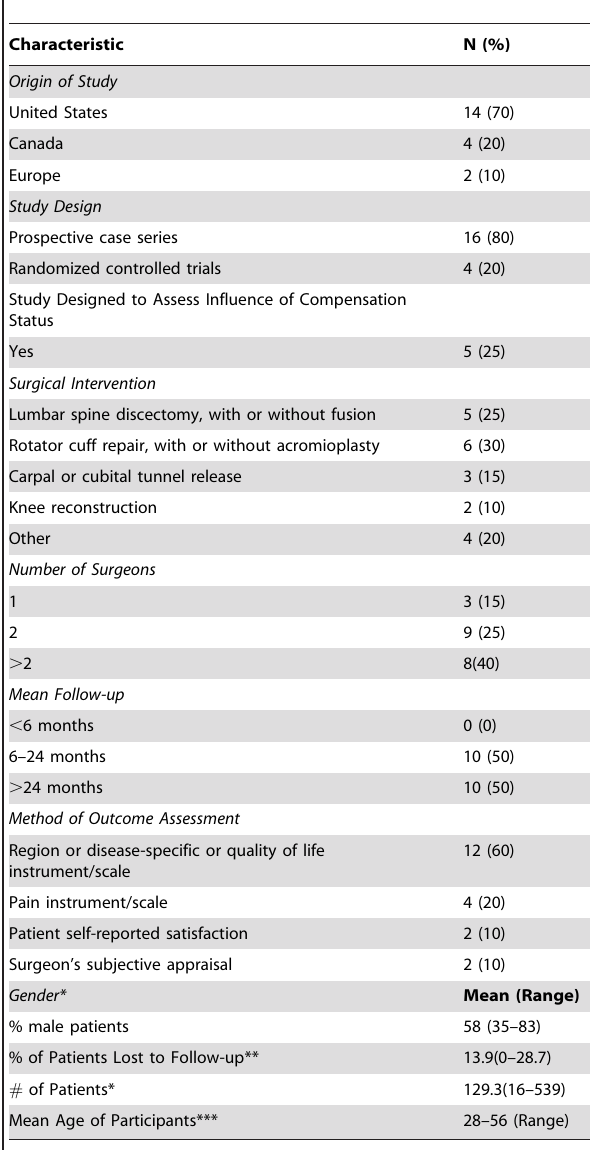
Table 1. Characteristics of Included